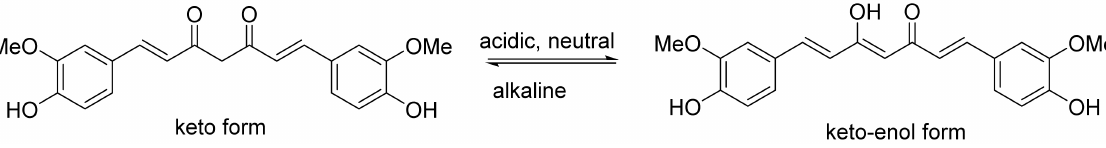
Figure 2. Tautomerism of curcumin under different pH